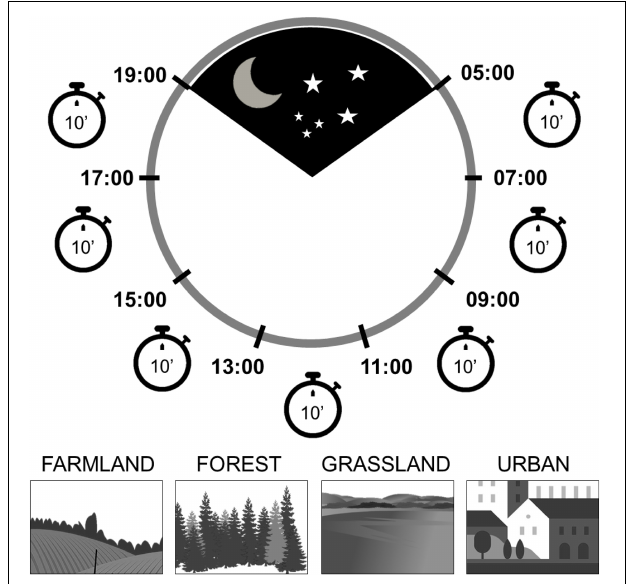
FIGURE 1 | The scheme of the survey program illustrates the coverage of the whole day using 10 min observations (point counts) distributed in each of the seven 2-h periods dividing the day, approximately from sunrise to sunset. The surveys were performed in four types of habitats: farmland, forest, grassland and urban